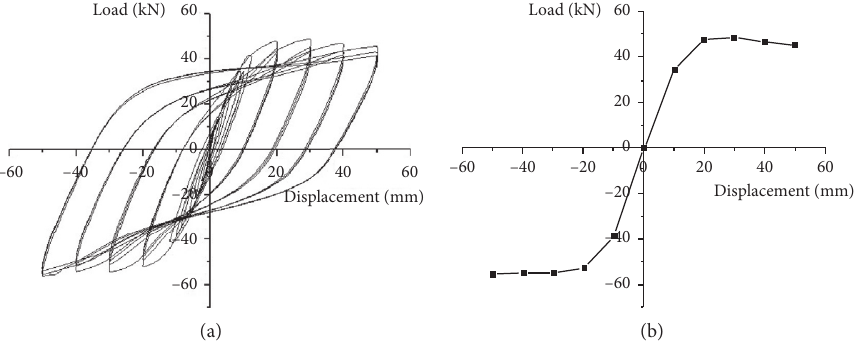
Figure 10: Hysteretic curve and envelope curve for